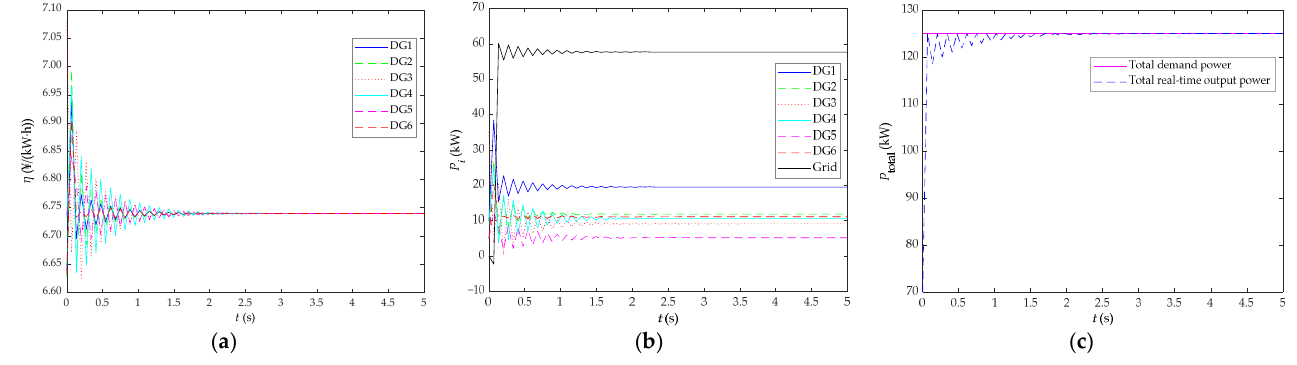
Figure 16. The change curves of variables of the system when ε is increased by 5 times: ( a ) change curves of each DG’s ICR; ( b ) change curves of each DG’s active output and grid output power; ( c ) change curves of the cumulative sum of each DG’s active output and grid output power as well as total demand power.